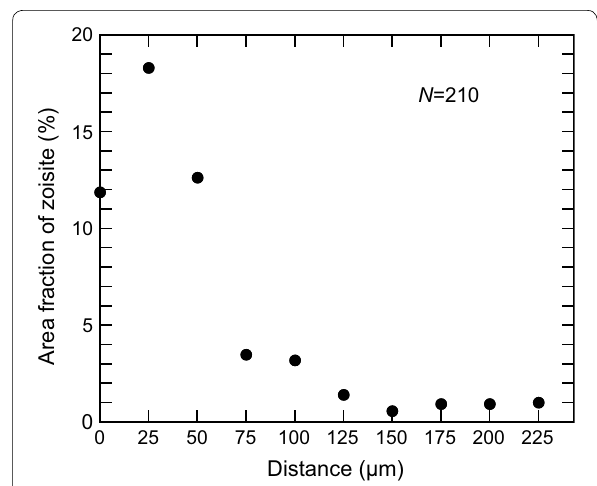
Fig. 7 Fractions of the zoisite grains visible under SEM images. The grains were traced at an interval of 25 μm toward the upper part of the sample (e.g., see Fig.